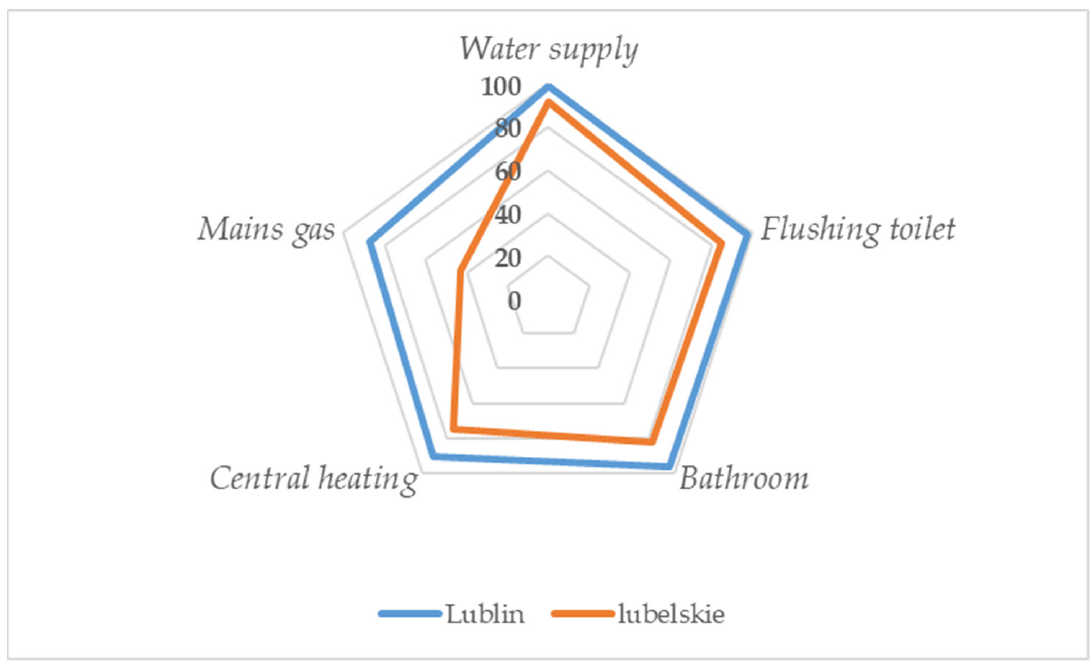
Figure 11. Indicators of housing infrastructure quality in Lublin and the Lublin Province.